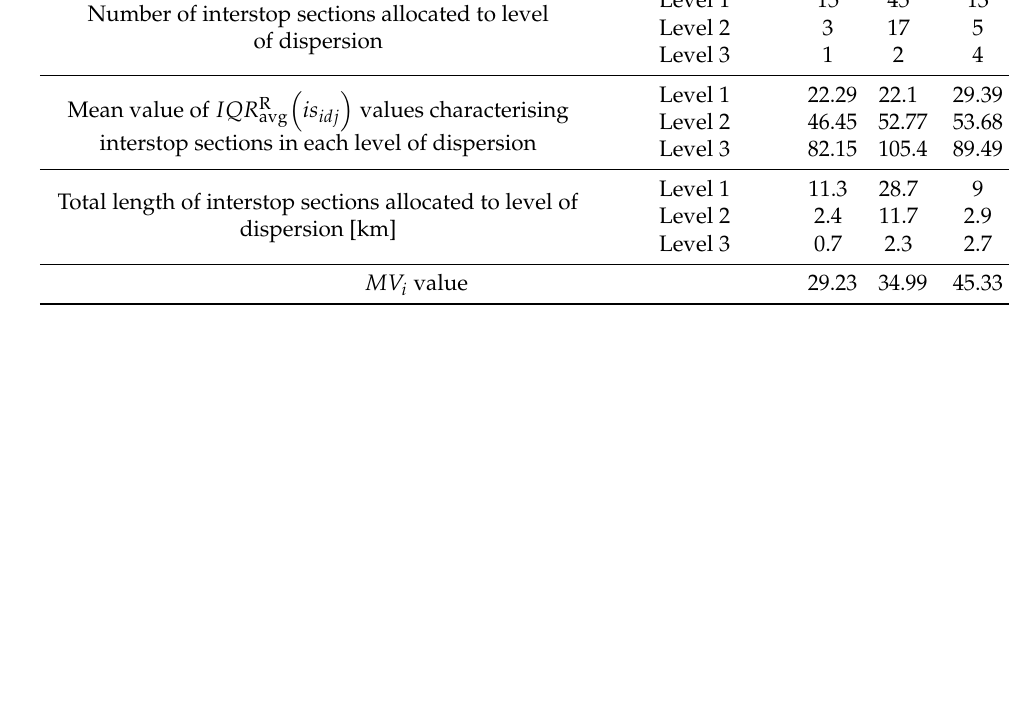
Attribute of Bus